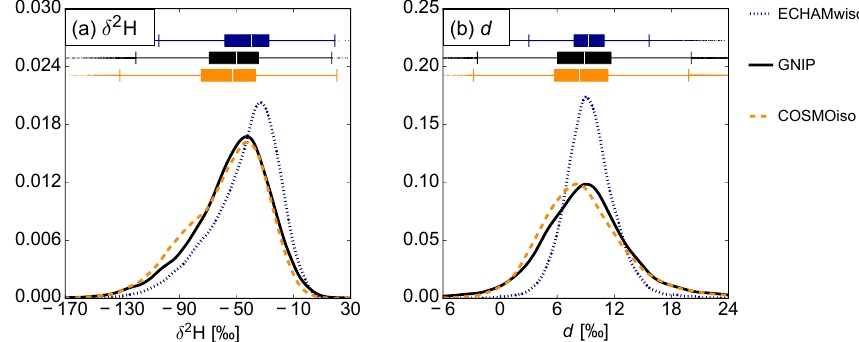
Figure 4. Box plots and probability density functions of the monthly mean (a) δ 2 H and (b) d in precipitation from ECHAMwiso (dark blue), COSMOiso (orange) and the GNIP measurements